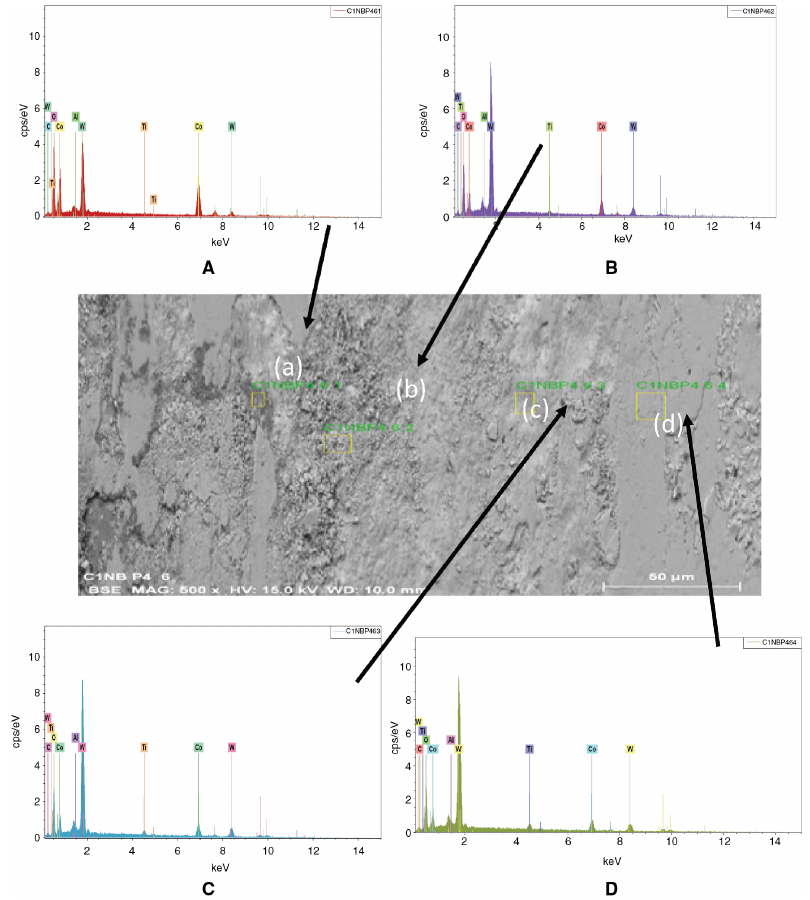
Figure 11: SEM micrographs of the wear track of grade (NB) WC-Co-5% TiC cermet when sliding against Al spectrums using temperature P2(T = 650°C) after (5000 m) of sliding.